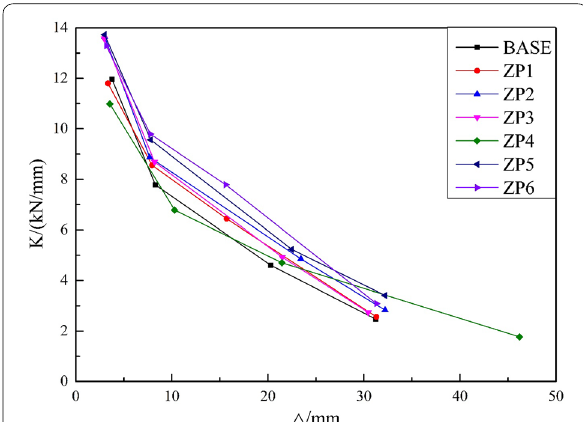
Fig. 10 Stiffness degradation curve of the specimens.